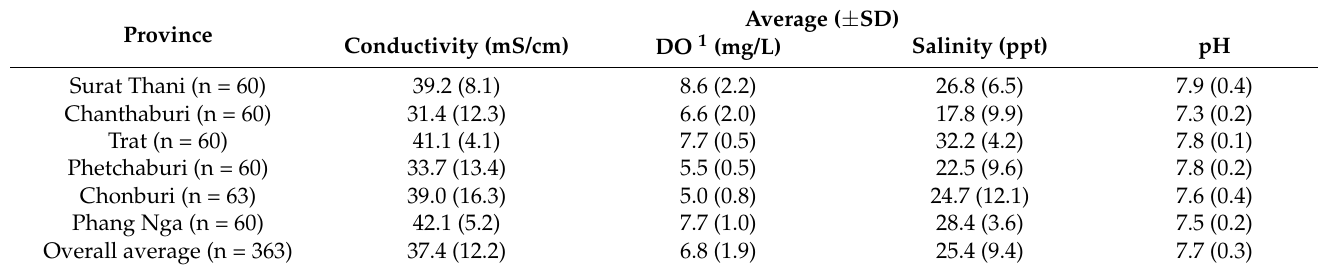
Table 3. Average and SD of coastal water quality parameters, stratified by province.